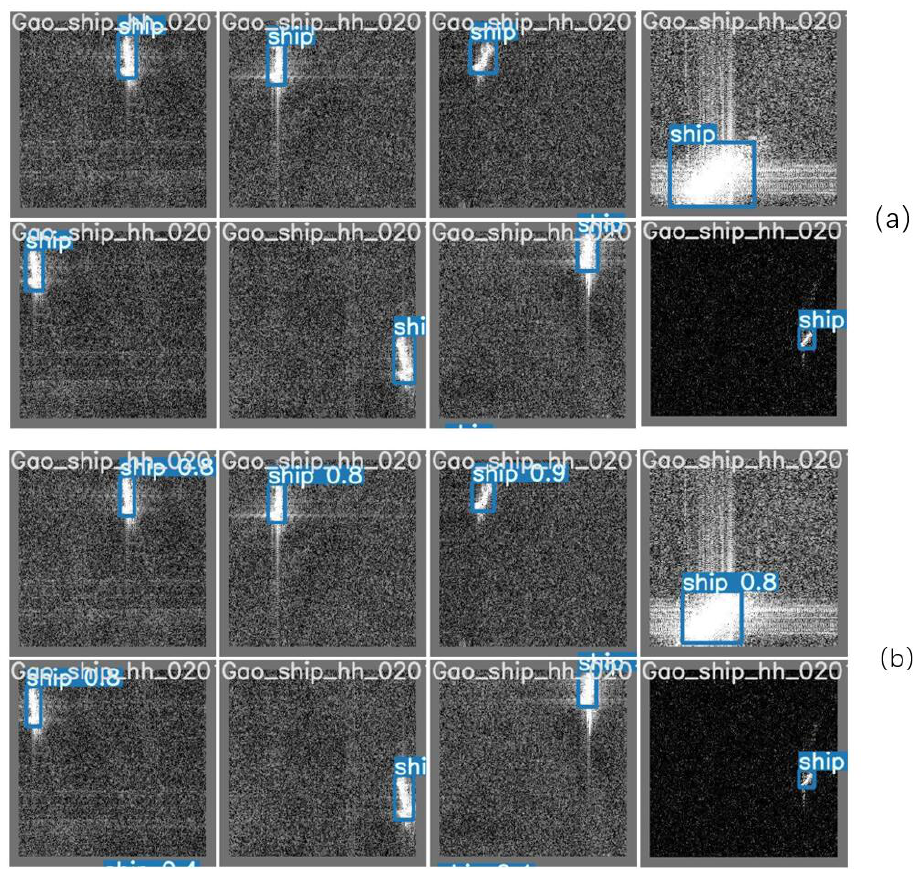
Figure 15. The visual analysis of the detection result of the proposed FASC-Net. ( a ) SAR images and labels. ( b ) The detection result.